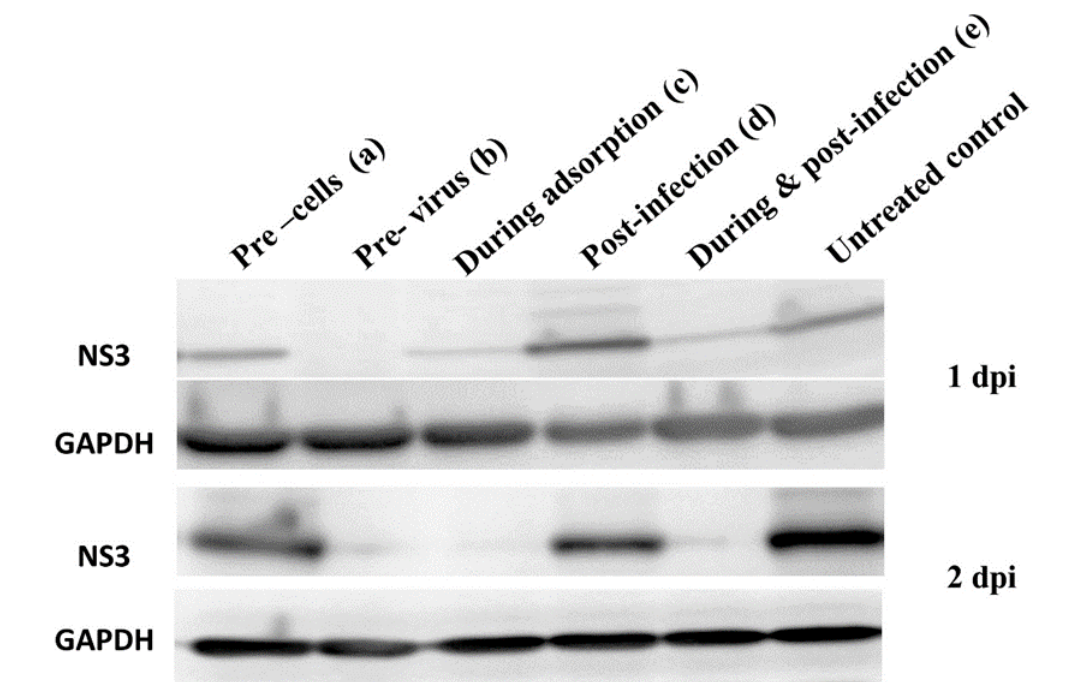
Figure 3. Effect of the addition of WV at various times during HCV infection on Huh7it-1 cells. JFH-1 HCV and WV (500 ng/mL) were added to Huh7it-1 cells at various time points. (a-e) Accumulation of HCV NS3 protein inside the cells. Virus-infected cells were analyzed by immunoblot using an anti-HCV NS3 antibody at 1 and 2 dpi. Signals of NS3 were normalized to the corresponding GAPDH signal. dpi: days